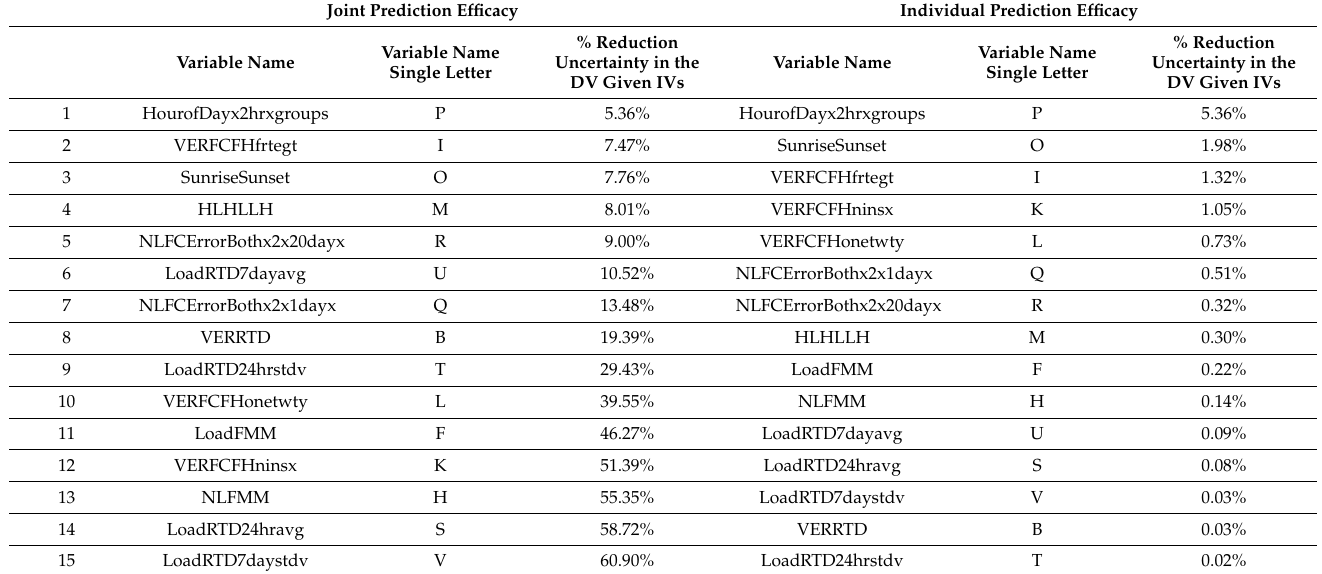
Table 7. Rank order of variables for Fold 5 * Best Overall Model. Joint Prediction Efficacy Individual Prediction